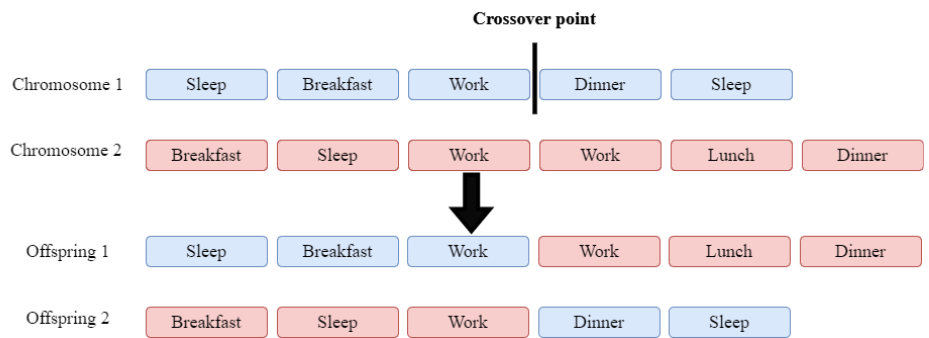
Figure 2. One-point crossover on two individuals representing daily activities sequence of a person. In two-point crossover, two different crossover points are generated that should have a smaller value than the length of the shortest parent. The two points are used to split both parents into three parts. The two offspring chromosomes will have the first and last subsequence of the same parent, but the middle sequence will be from the other parent (see Figure 3).